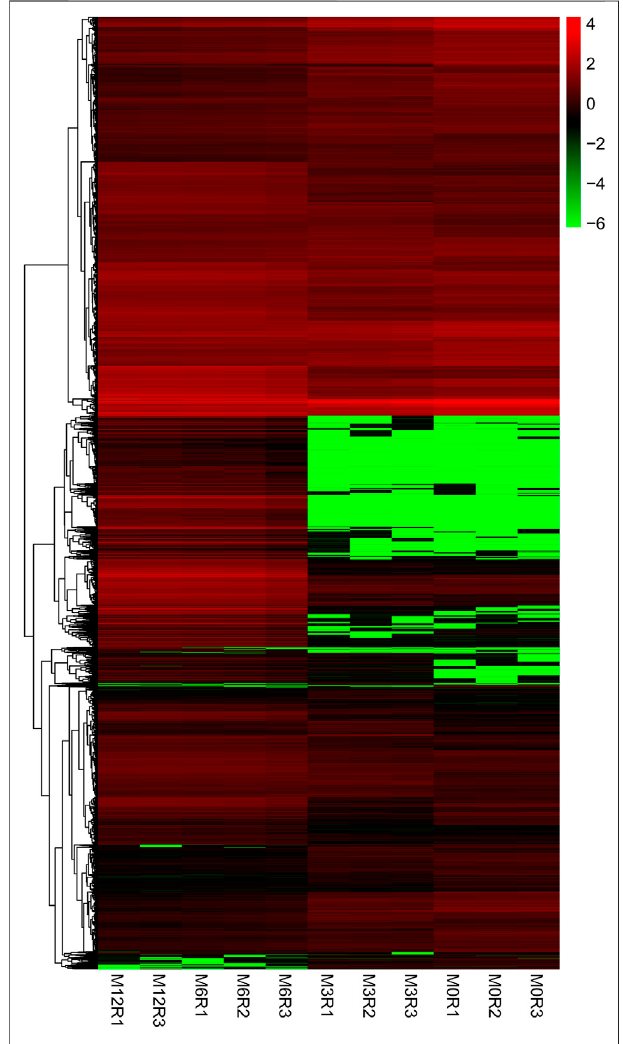
FIGURE 2 | Hierarchical clustering of genes expression from M0, M3,